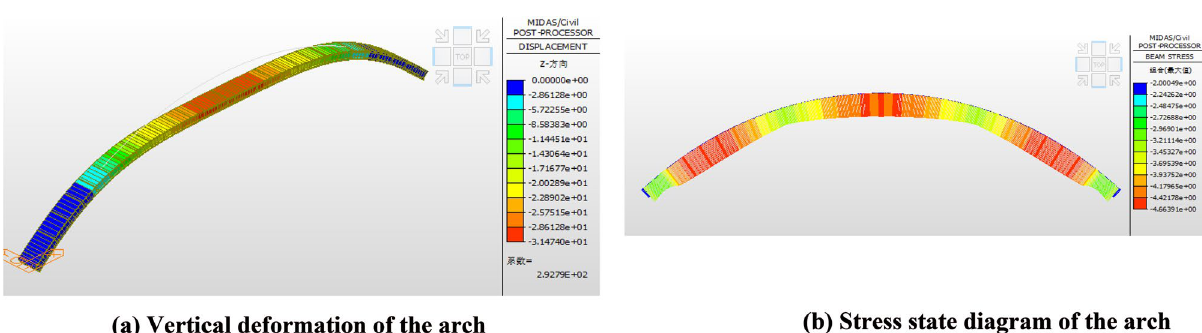
Figure 11. The simulation sequence of the construction phase.